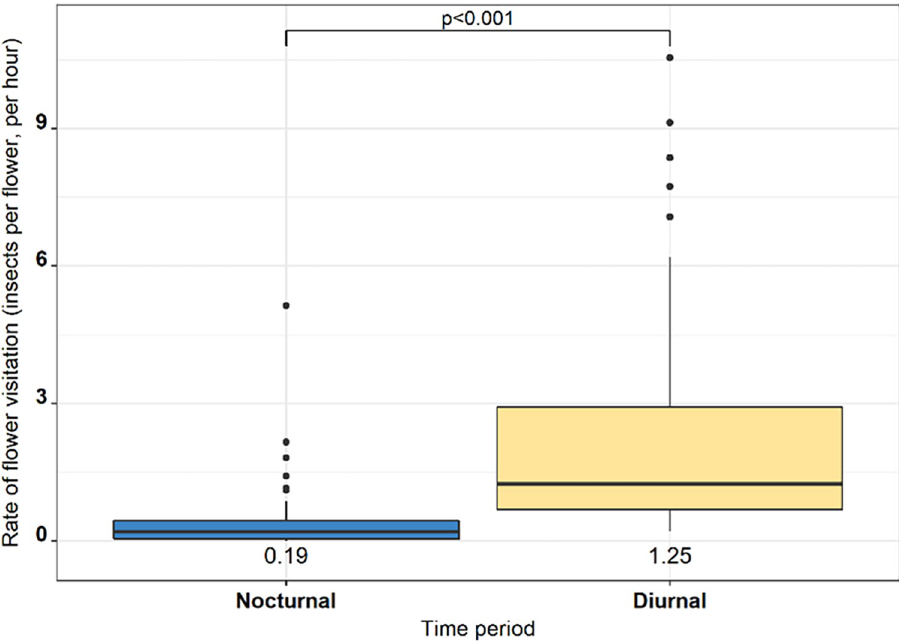
Fig 2. Box plot comparing the rate of flower visitation by all insects (flower -1 hour -1 ) between nocturnal and diurnal time periods. Black dots represent outlying data points with median values presented beneath each plot.